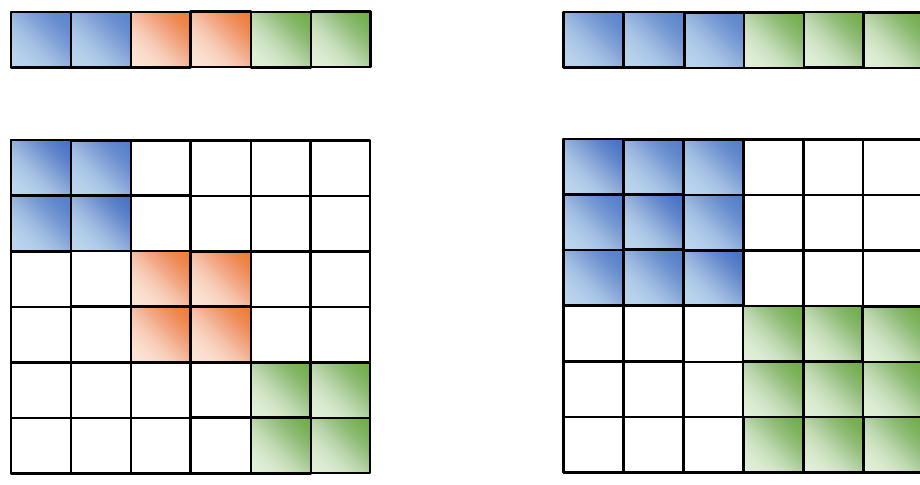
Figure 4. Different attribute subspace sizes under the same entity dimension. The dimension of each attribute subspace is set to 2 in the left and 3 in the